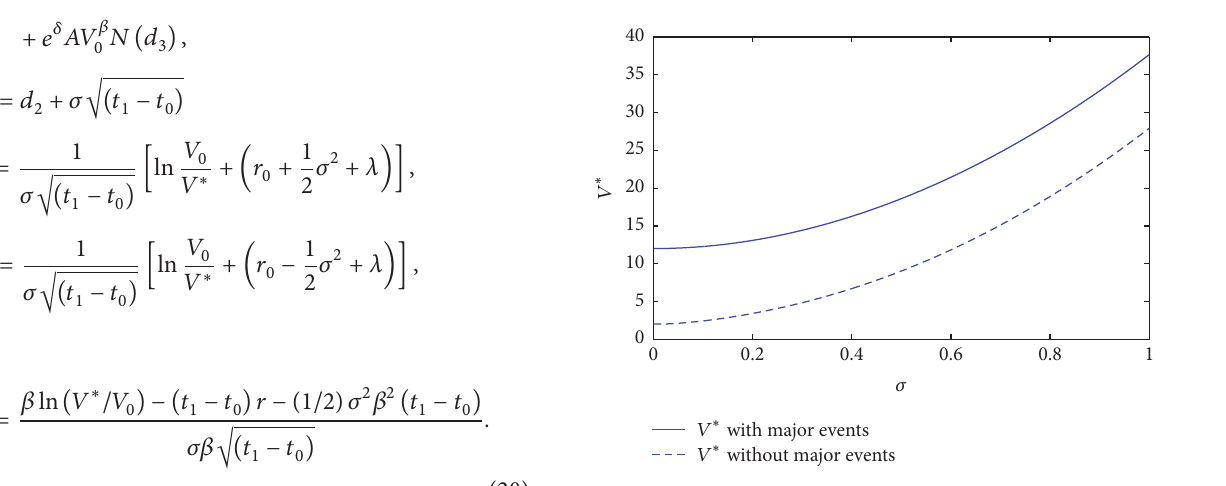
Figure 1: The relationship between the funding threshold 𝑉 ∗ and marketuncertainty 𝜎 with(solidline)orwithout(dashedline)major events. Solid line: 𝜆 = 0.2; 𝑟 = 0.04 ; 𝛿 = 0.02; 𝐼 1 = 1. Dashed line: 𝜆 = 0; 𝑟 = 0.04 ; 𝛿 = 0.02 ; 𝐼 1 = 1.